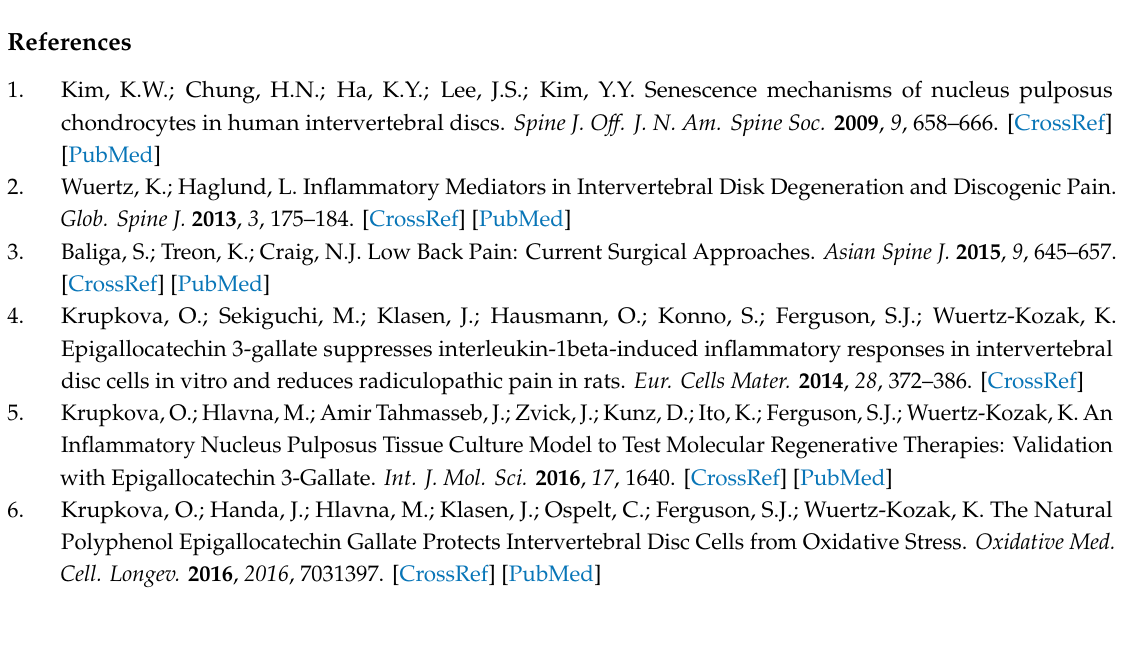
Figure S1: Scanning electron microscopy images of electrosprayed 4% and 6% gelatin particles crosslinked with 37.5 µ g / mL, 62.5 µ g / mL, and 87.5 µ g / mL glutaraldehyde (GA) and sprayed at flow rates 2 µ L / min and 4 µ L / min. Figure S2: The release of IL-6 from disc cells cultured in 3D for seven days in the presence of 5 ng / mL IL-1 β with and without EGCG microparticles. Figure S3: Korsmeyer–Peppas model of drug release kinetics. Figure S4: Representative SEM image of EGCG particles produced using NANOSPIDER ™ technology in 10k magnification and 5k magnification. Table S1: Examined electrospraying parameters (NANOSPIDER ™